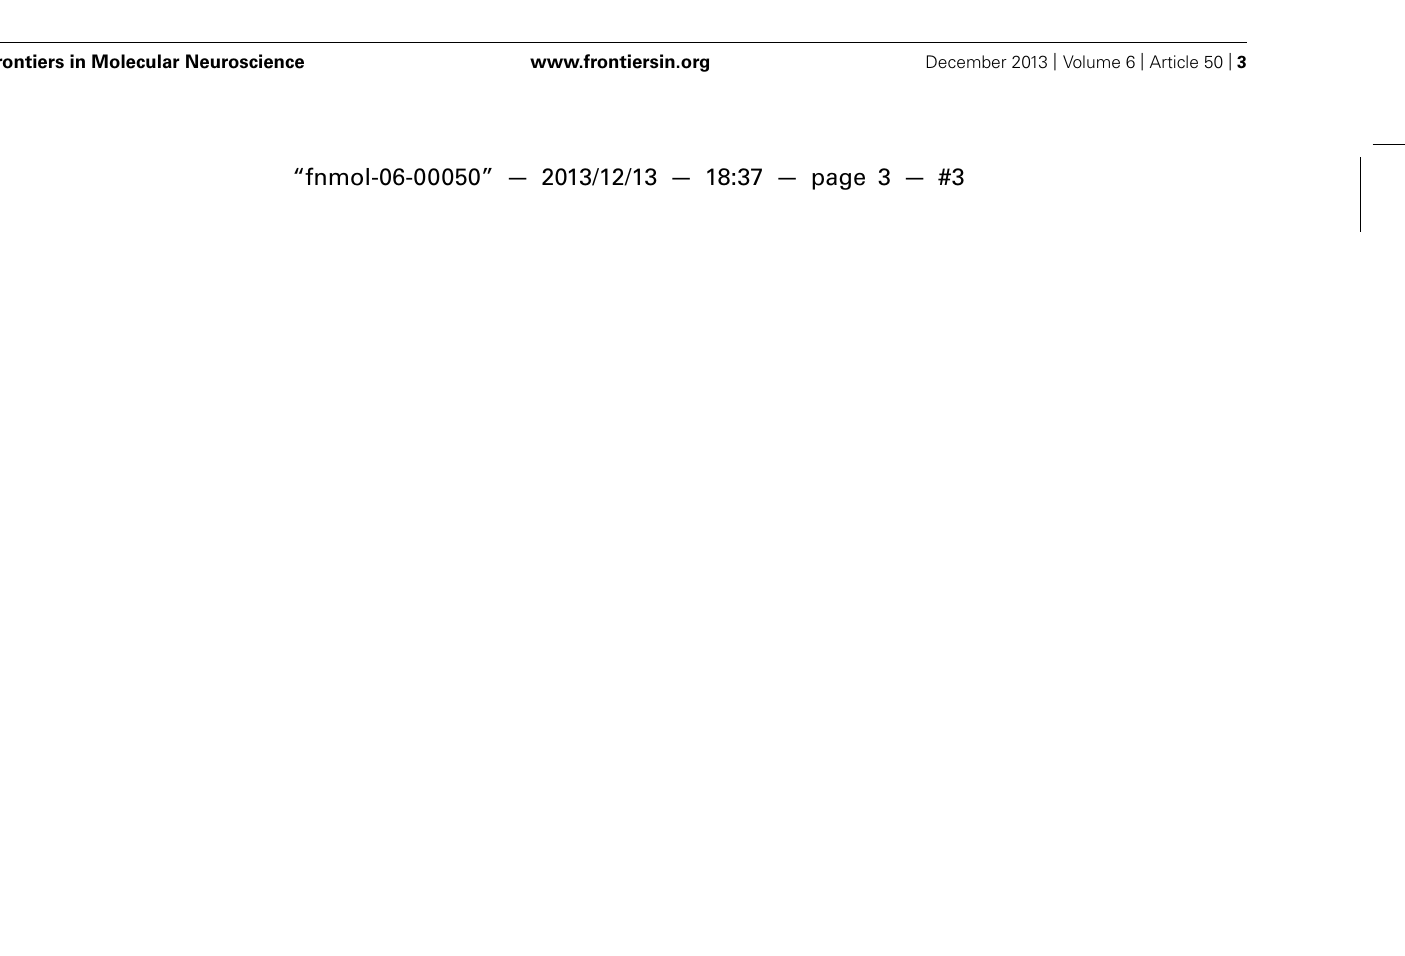
FIGURE 2 | Effects of repetitiveTMS (rTMS) on single neurons within a network. (A) DuringTMS axons with a particular orientation within the induced electric field are depolarized.This leads to anterograde propagating action potentials (aAP). In addition,TMS may also initiate backward propagating APs (bAP) in the target neuron, or even directly depolarize specific dendritic segments (indicated by orange color).TMS-effects on other